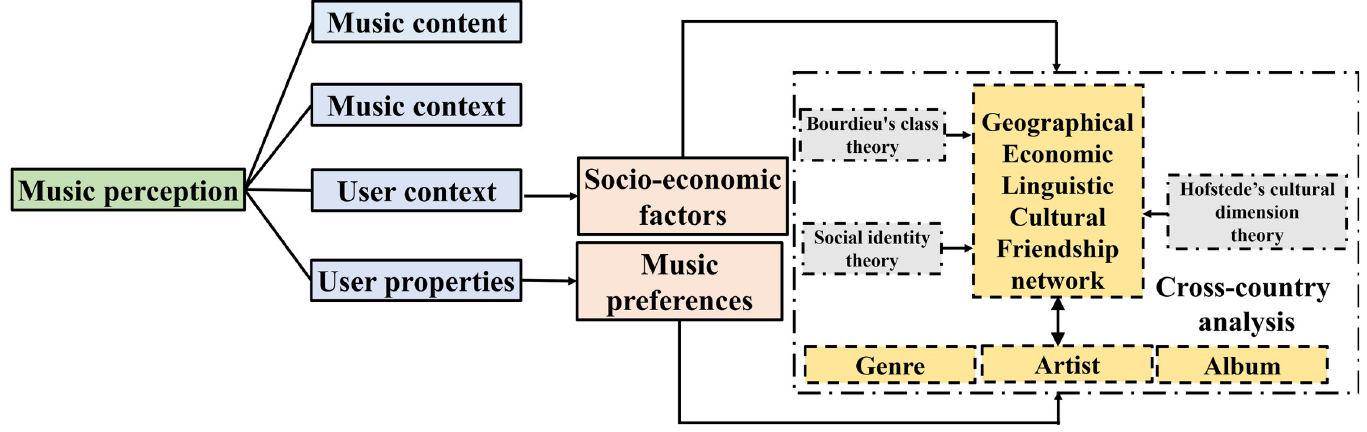
Fig 1. The theoretical framework of this